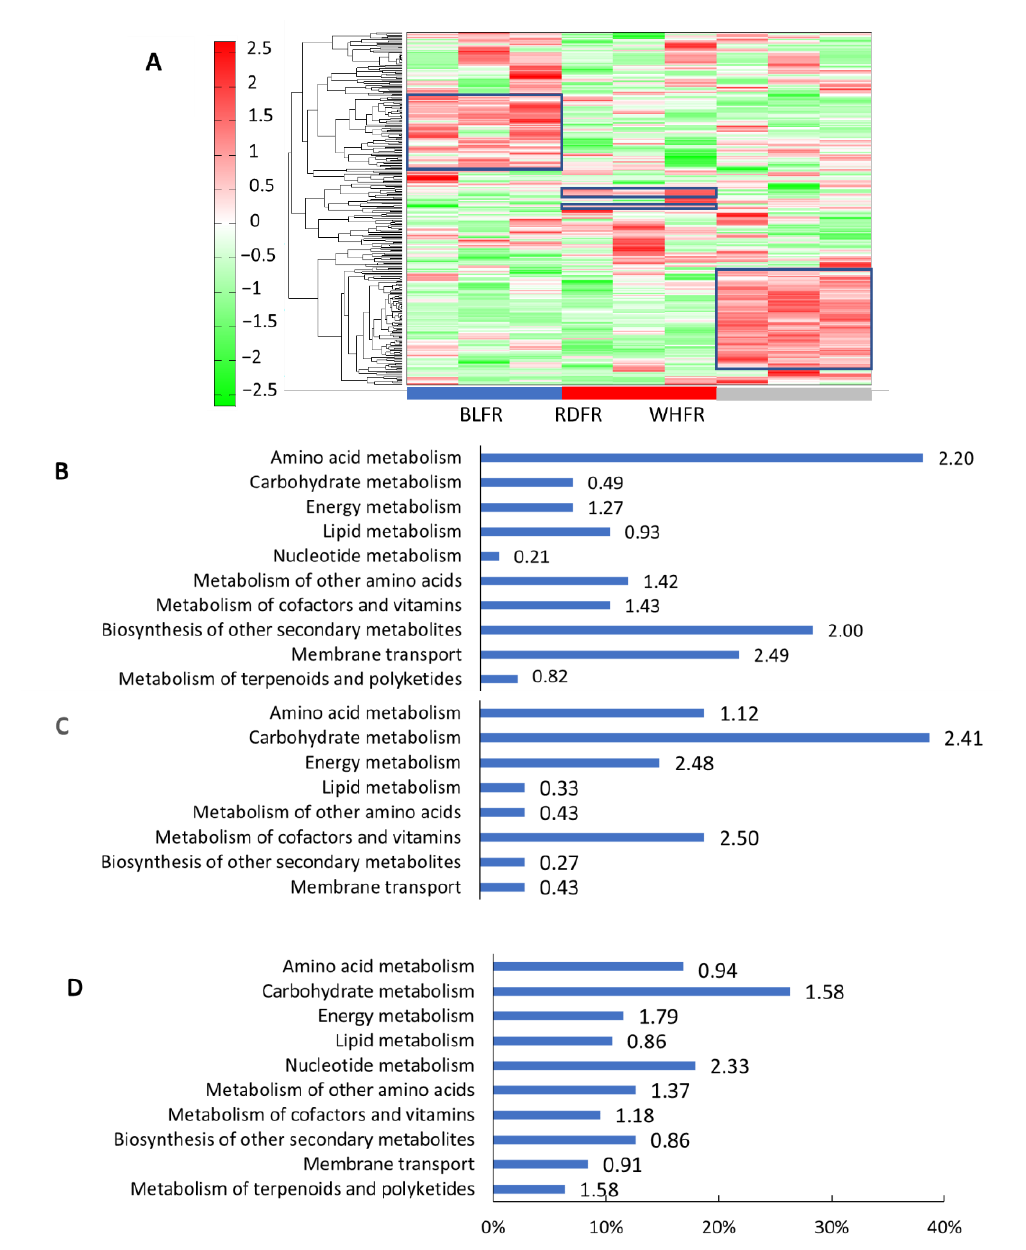
Figure 1. PCA of metabolic profiles in fruits with different light treatments. PCA scores are pre- sented based on a combination of the first (PC1) and second (PC2) principal components and vari- ances of each component in the sample set. BLFR, RDFR, and WHFR refer to blue, red, and white light-treated fruits.